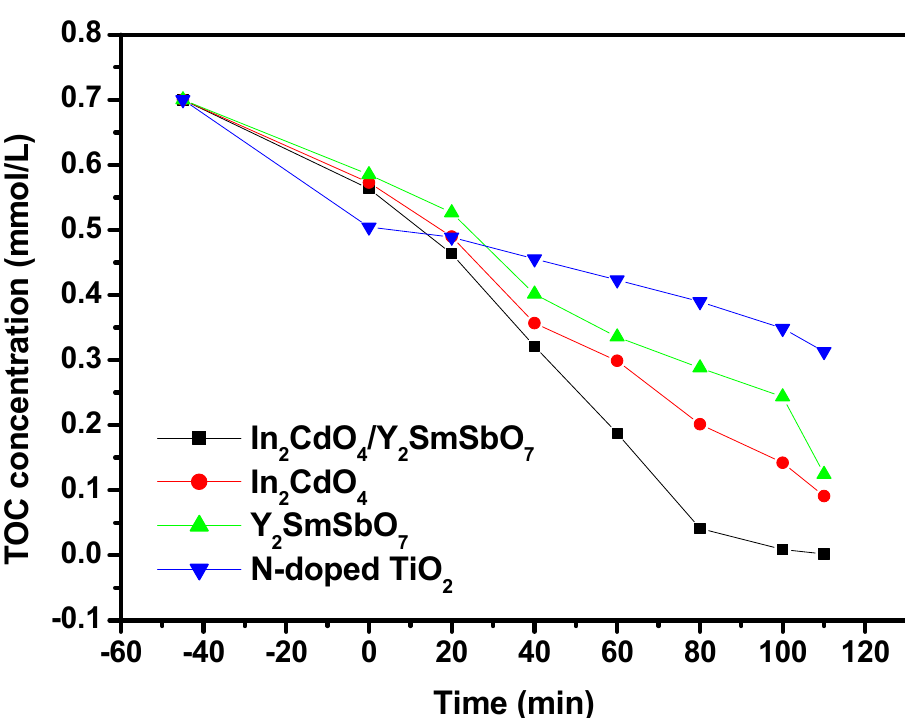
Figure 15. Concentration change curves of TOC during PCD of rhodamine B in dye wastewater with In 2 CdO 4 /Y 2 SmSbO 7 nanocomposite, In 2 CdO 4 , Y 2 SmSbO 7 , or N-TO as the photocatalyzer under visible light irradiation.